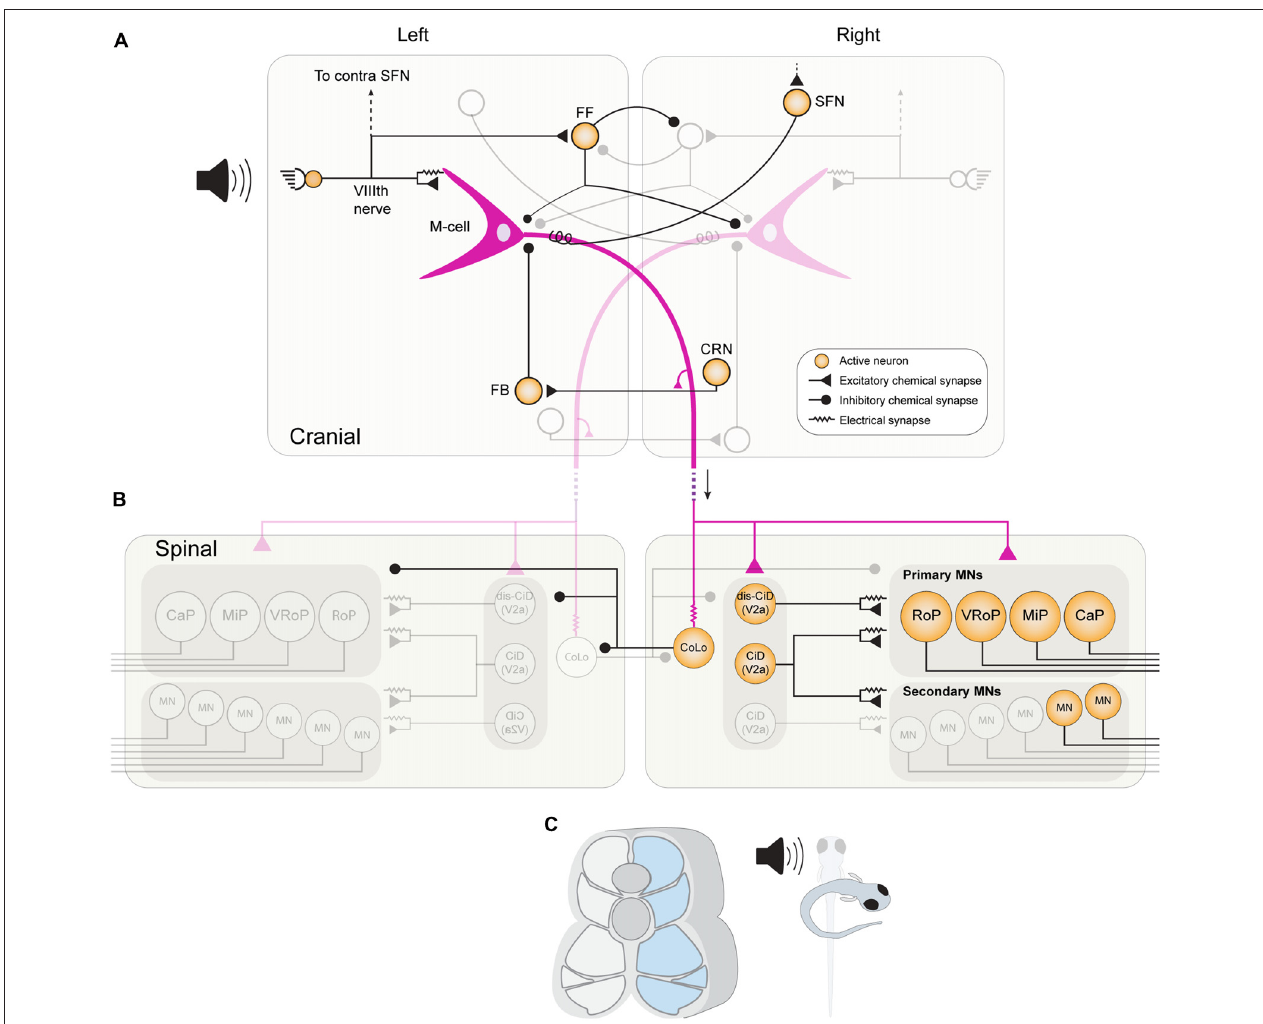
FIGURE 3 | The brainstem and spinal cord network in larval zebrafish for mediating a fast-onset C start response. (A) An acoustic stimulus from the left stimulates afferent hair cells, which provide direct excitation to the left M-cell (purple) via mixed chemical and electrical synaptic boutons. Afferent hair cells also provide convergent excitation to the ipsilateral M-cell via activation of spiral fiber neurons (SFNs). The afferent hair cells also stimulate a population of feedforward (FF) inhibitory INs, which mostly inhibit the contralateral M-cell and contralateral FF inhibitory neurons. As the M-cell spike propagates down its axon it stimulates cranial relay neurons (CRNs) via axon collaterals, which activate feedback (FB) inhibitory INs that prevent the M-cell from generating consecutive spikes. (B) When the M-cell axon reaches the spinal cord, it provides direct chemical excitation of primary MNs on the right side, as well as to excitatory CiD INs. CiD INs provide further excitation via mixed chemical and electrical synapses to primary and fast secondary MNs. Finally, the M-cell axon also rapidly excites inhibitory Commissural local INs (CoLos) via electrical synapses, which in turn inhibit various MNs and INs on the contralateral side. (C) The activation of this escape network results in strong contraction of fast musculature on the right side of the body, resulting in fish curving into the characteristic